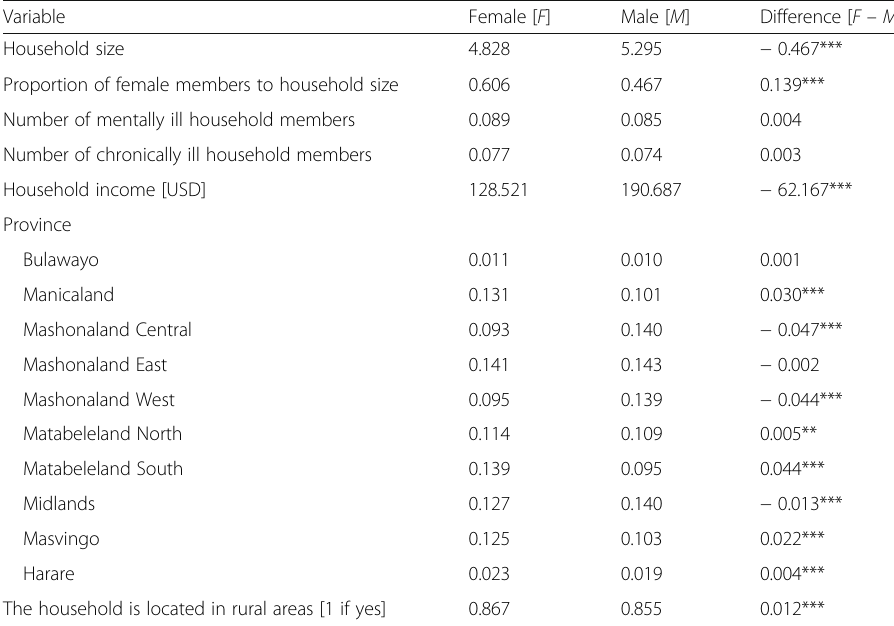
Table 3 Background of households Variable Female [ F